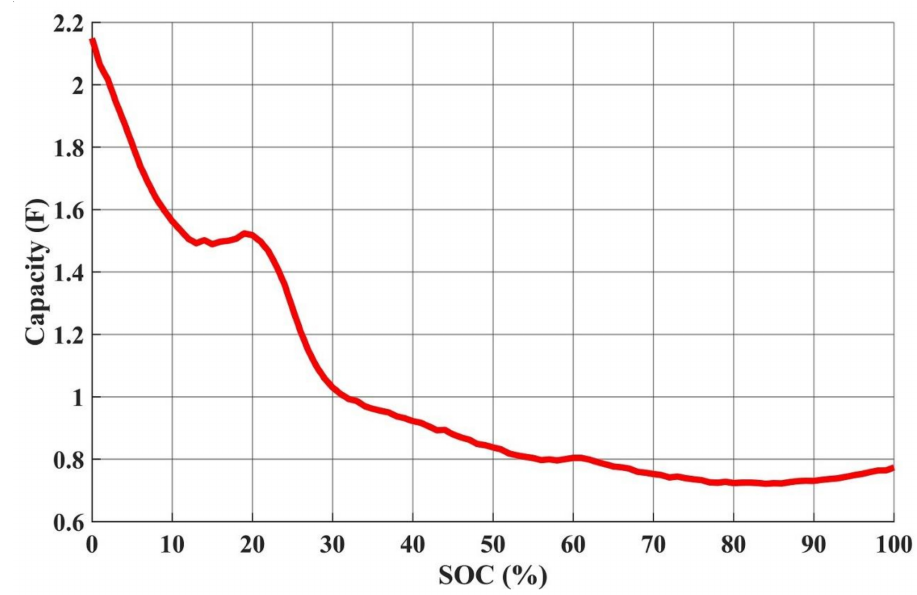
Figure 6. Relationship between shunt equivalent capacitor ( C p ) and SOC.